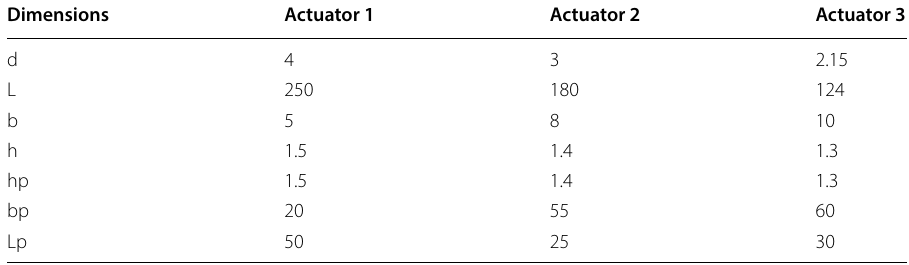
Table 1 Dimensions of three different actuators